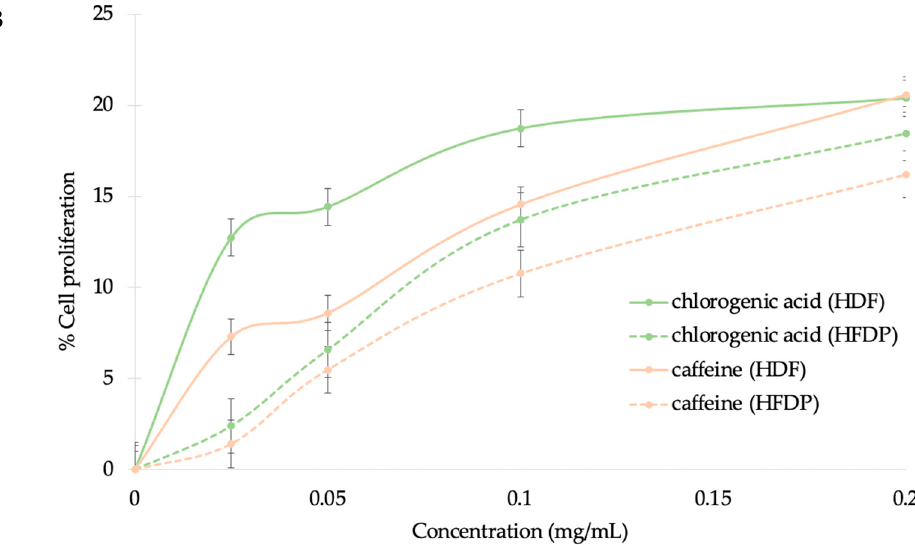
Figure 3. HDF and HFDP cell proliferation effect of various concentrations of CBE (A), caffeine, and chlorogenic acid (B).